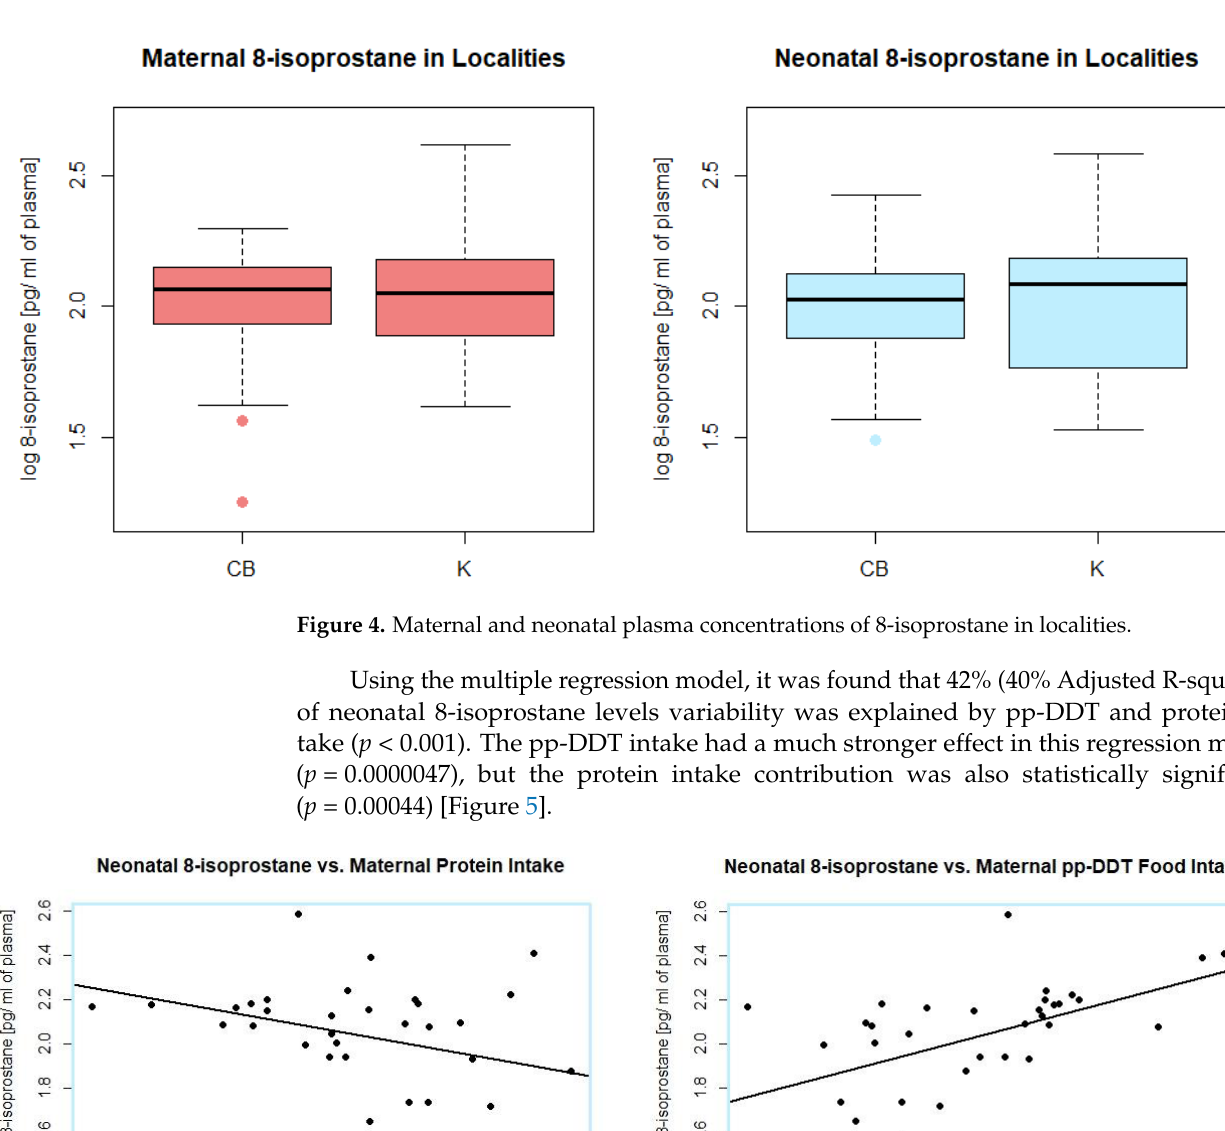
Figure 6. Relationships between neonatal plasma concentrations of 8-isoprostane and maternal fruit and vegetable intake. 4. Discussion There were two main aims of our study. First, to examine the diet quality of pregnant women, including exposure to POPs, in the Czech Republic. Second, to analyze the rela- tionship between maternal diet during pregnancy (including POPs intake) and the birth weight and neonatal levels of oxidative stress. The results of our study indicate that the diet quality of Czech pregnant women does not meet the recommended standards. In total, 63% of mothers did not have sufficient protein intake and 90% of mothers had low fiber intake. In our cohort, there were no moth- ers with an adequate intake of raw vegetables and dairy products. In the Czech Republic, good quality food is available all year round in a very dense retail network. The Czech Republic is a developed welfare state with many social benefits. The vast majority of the population has the financial means to buy good quality food. All study participants were asked about their financial situation. No one reported financial problems that would force them to limit their living needs. Thus, there are no external obstacles preventing women from accessing good quality food here. However, it should be taken into account that we only analyzed the diet of a small number of subjects over a short period of time. The ques- tion is whether the results are representative of the entire population.